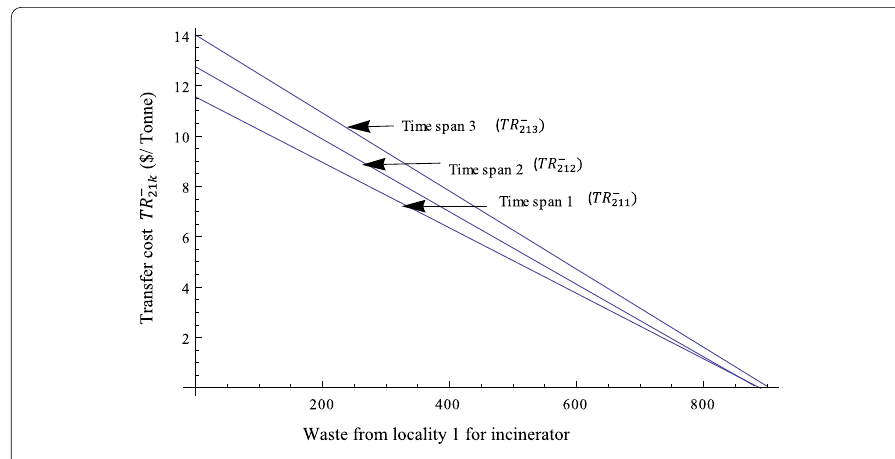
Figure 5 Lower bound of waste collection and transfer cost from locality 1 to the incinerator